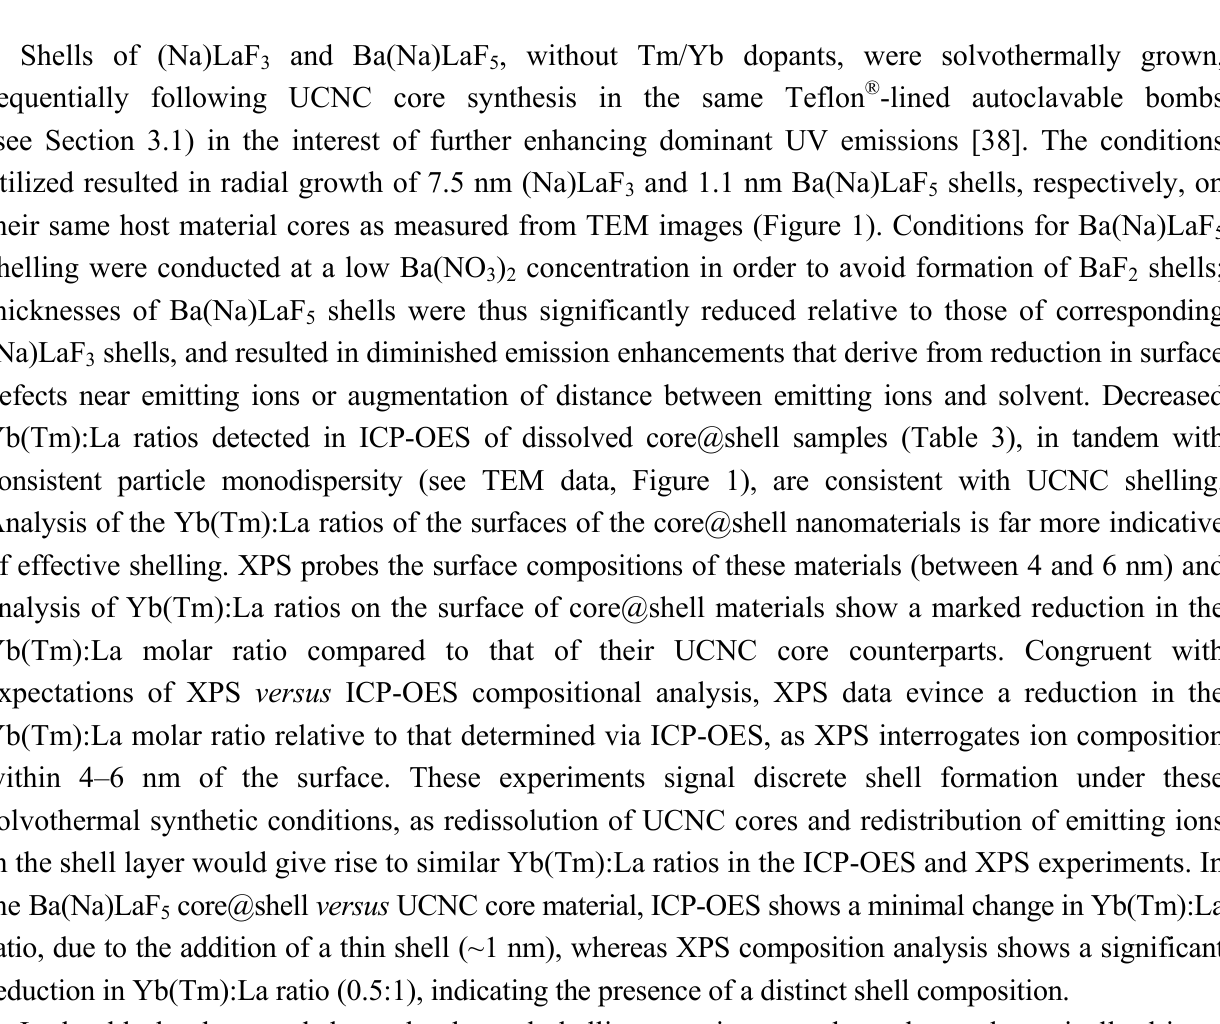
Table 3. XPS survey scans of (Na)LaF